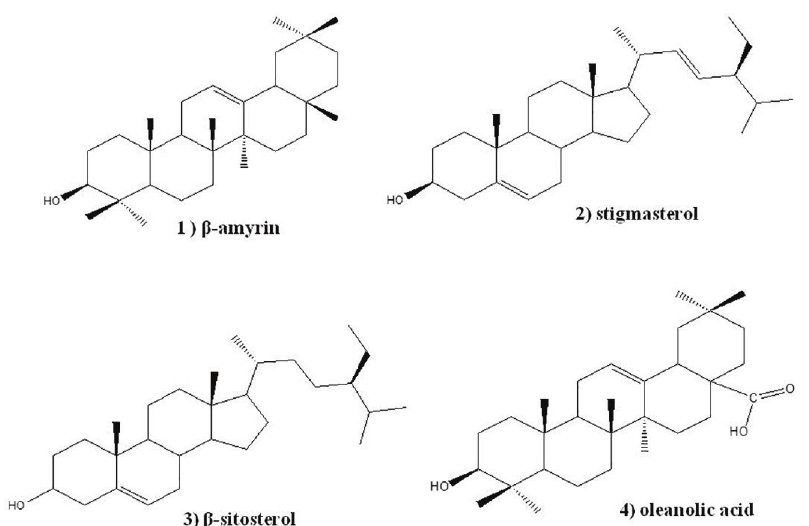
FIGURE 2 - Isolated and identified compounds from Passiflora mucronata leave extracts.